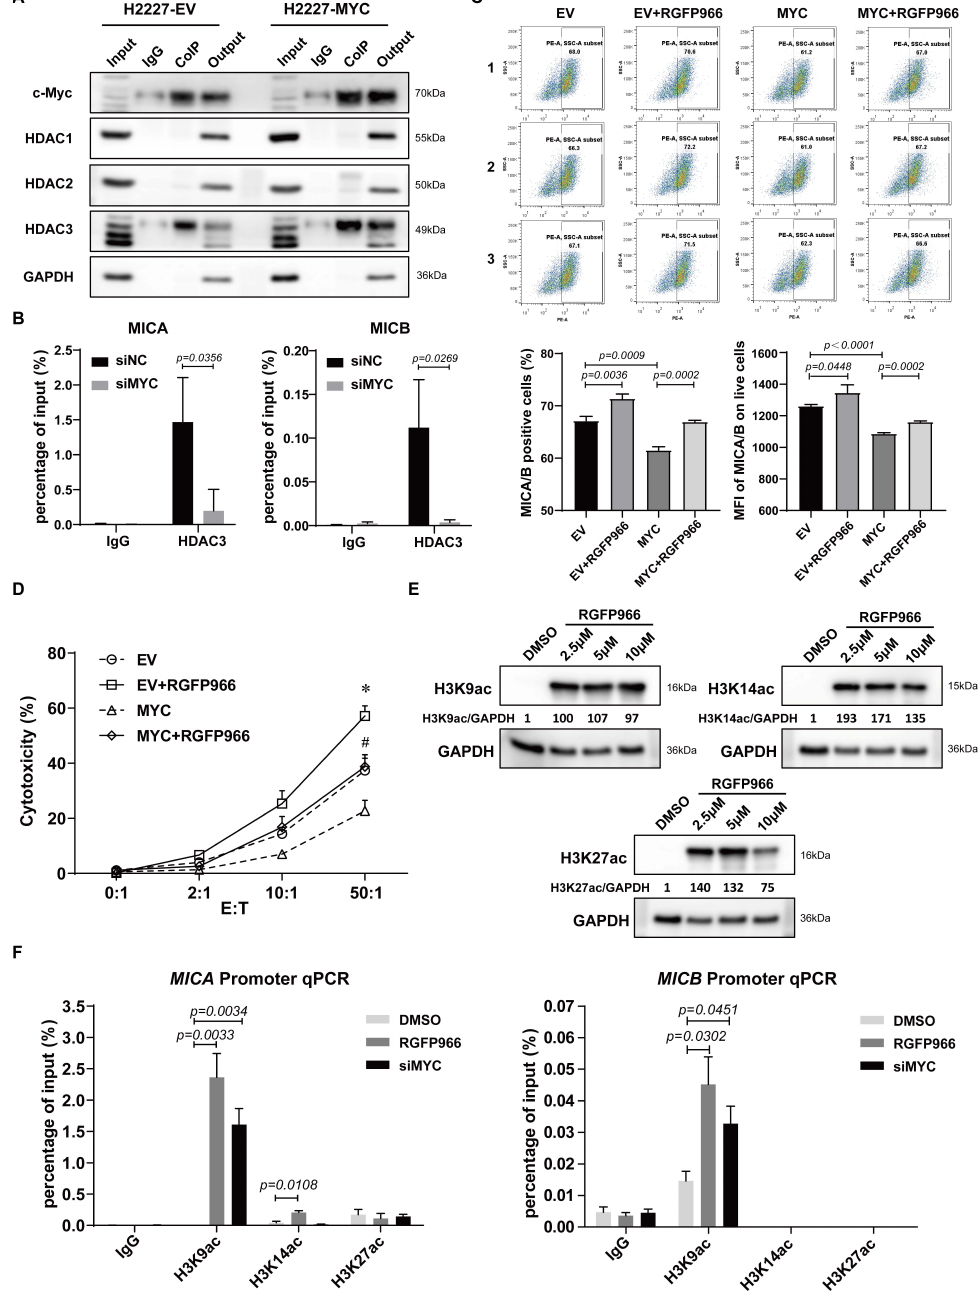
Figure 4. c-Myc modulated HDAC3 to deacetylate histone H3K9ac at MICA and MICB promoters. ( A ) Co-IP assay of the binding of c-Myc with HDAC1, HDAC2, or HDAC3 in H2227 cells transfected with or without MYC-OE. ( B ) ChIP-qPCR analysis of the binding of HDAC3 and MICA/B promoter in MYC -silencing H2227 cells. ( C ) Flow cytometry analysis of MICA/B expression in H2227 cells transfected with EV or MYC-OE followed the treatment of RGFP966 (10 µ M) or not. ( D ) LDH analysis of the susceptibility to NK-92MI cell killing of H2227 cells transfected with EV or MYC-OE followed by the treatment of RGFP966 (10 µ M) or not. ( E ) Western blotting analysis of H3K9ac, H3K14ac, and H3K27ac in H2227 cells treated with or without RGFP966 (2.5 µ M, 5 µ M, and 10 µ M). ( F ) ChIP-qPCR analysis of H3K9ac, H3K14ac, and H3K27ac enrichment at MICA promoter and MICB promoter in H2227 cells treated with or without RGFP966 (10 µ M) or transfected with siMYC. Data are represented as mean ± SD ( n = 3). *, #, p < 0.05; * p : EV + RGFP966 group vs. EV group; # p : MYC + RGFP966 group vs. MYC